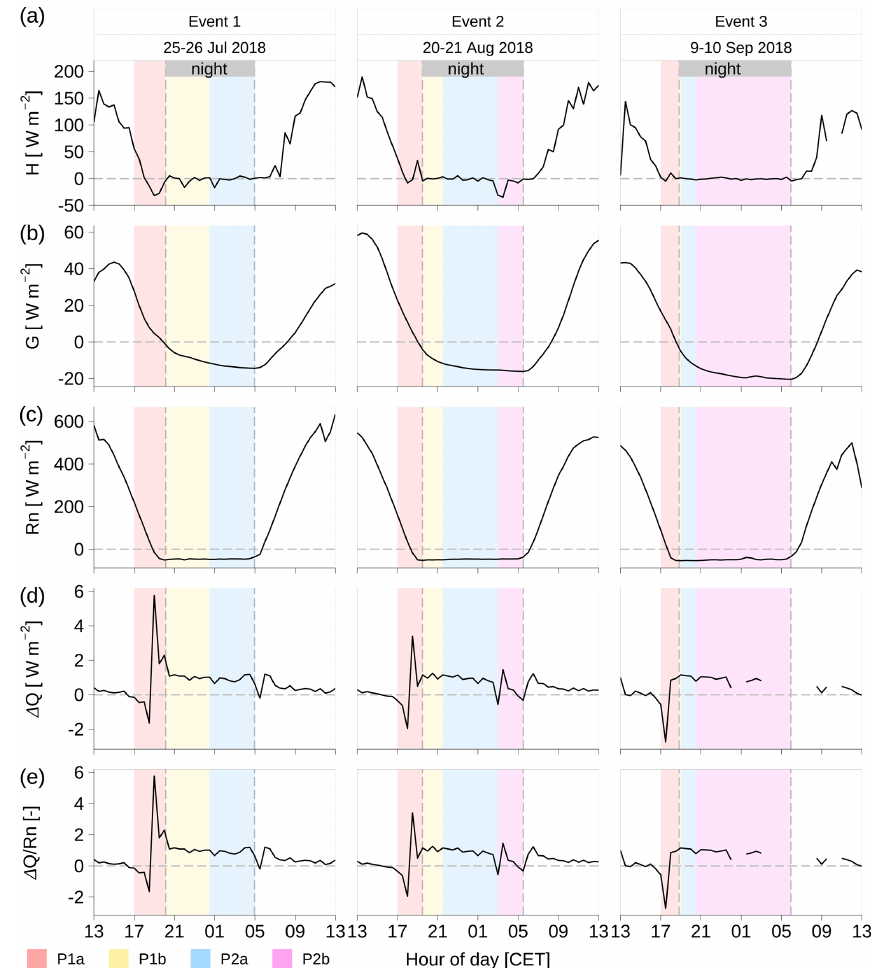
Figure 11. The 30min heat flux measurement during the three events: (a) H is the sensible heat flux; (b) G is the ground heat flux; (c) Rn is the net radiation flux; (d) (cid:49)Q is the budget closure term which accounts for all unmeasured advective fluxes and for the measurement errors of the measured fluxes. (e) (cid:49)Q/ Rn is the ratio of budget closure term (cid:49)Q to net radiation flux Rn. Vertical dashed lines show local sunset and sunrise times. The shaded areas indicated different periods of environmental conditions as described in Sect. 4.1. The P1a period was from around 17:00CET until sunset with the weakening of turbulence and the increase of specific humidity; the P1b period was from sunset until the first sign of condensation with short-term fluctuations of specific humidity; the P2a period was the dew formation period in the conditions of relative humidity < 100%; the P2b period was the combined dew and radiation fog period in the conditions of relative humidity =